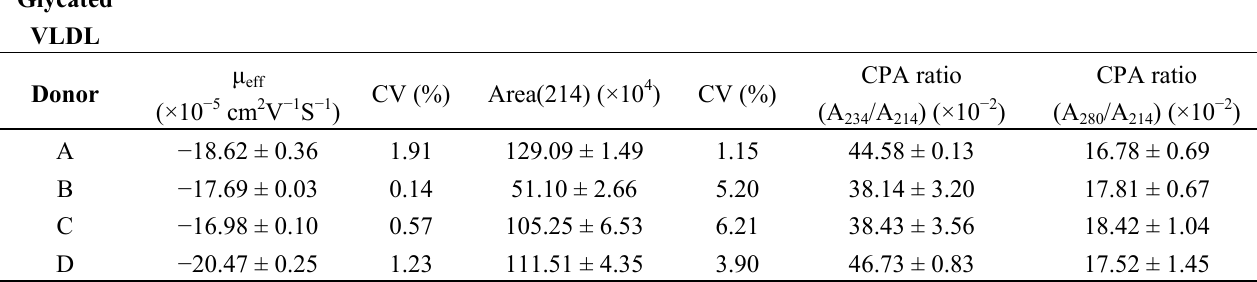
Table 3. The average effective mobility, peak area and peak area ratios of in vitro glycated VLDL particles analyzed by CZE (data are means ± SD of four